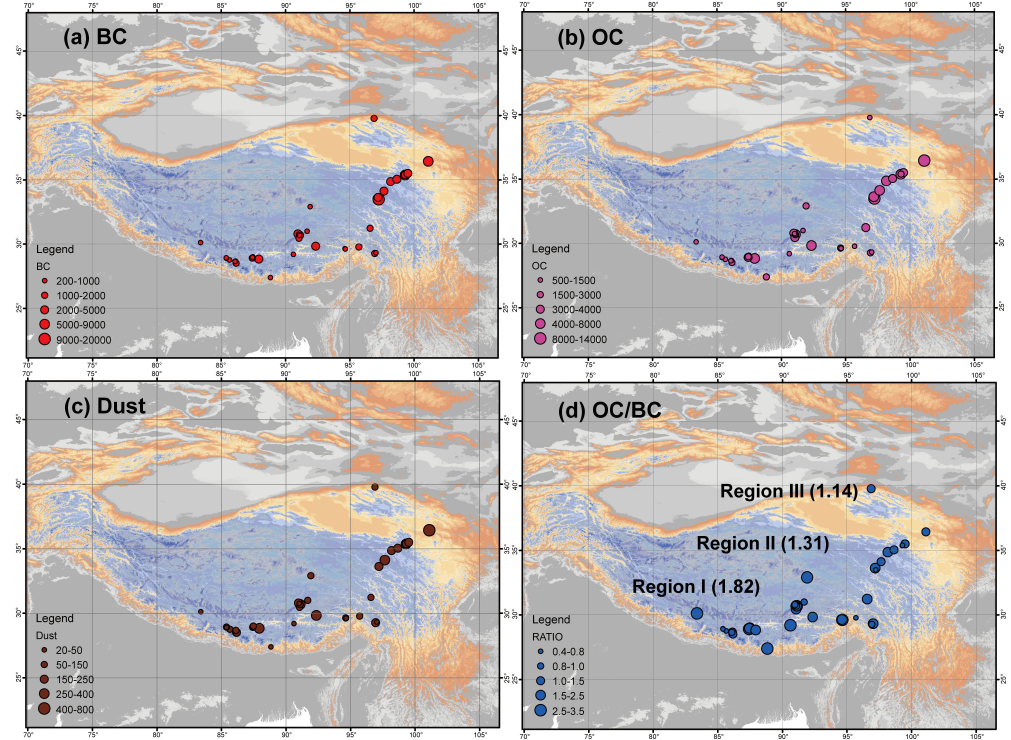
Figure 2. Spatial distributions of light-absorbing impurities in snow cover for each sampling site over the Tibetan Plateau. (a) BC (ngg − 1 ), (b) OC (ngg − 1 ), (c) dust (µgg − 1 ), and (d) ratio of OC to BC (OC /